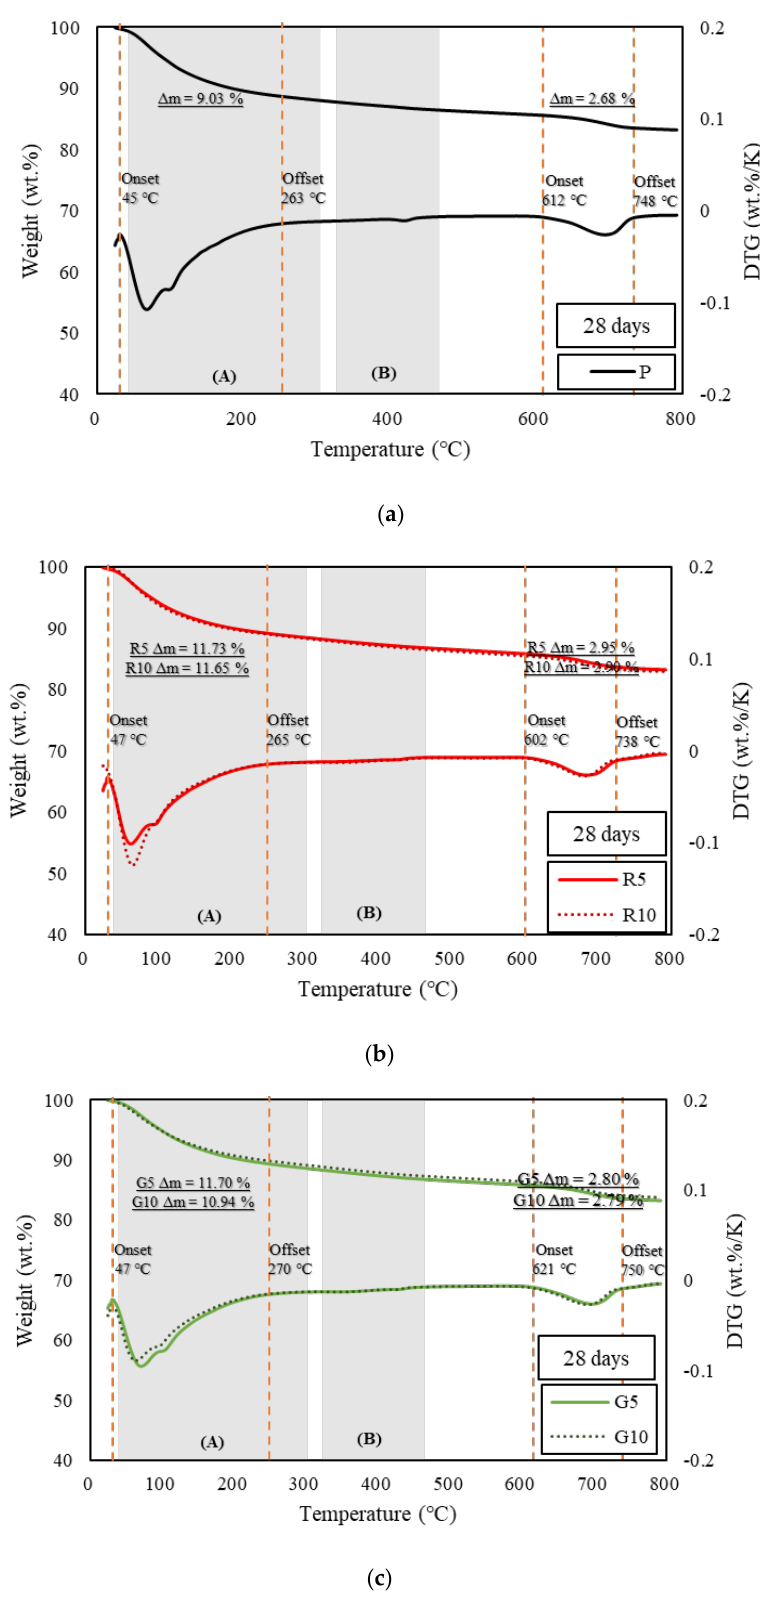
Figure 5. TGA of samples at 28 days. ( a ) TGA results of specimen P at the age of 28 days, ( b ) TGA results of specimens R5 and R10 at the age of 28 days, and ( c ) TGA results of specimens G5 and G10 at the age of 28 days. at the age of 28